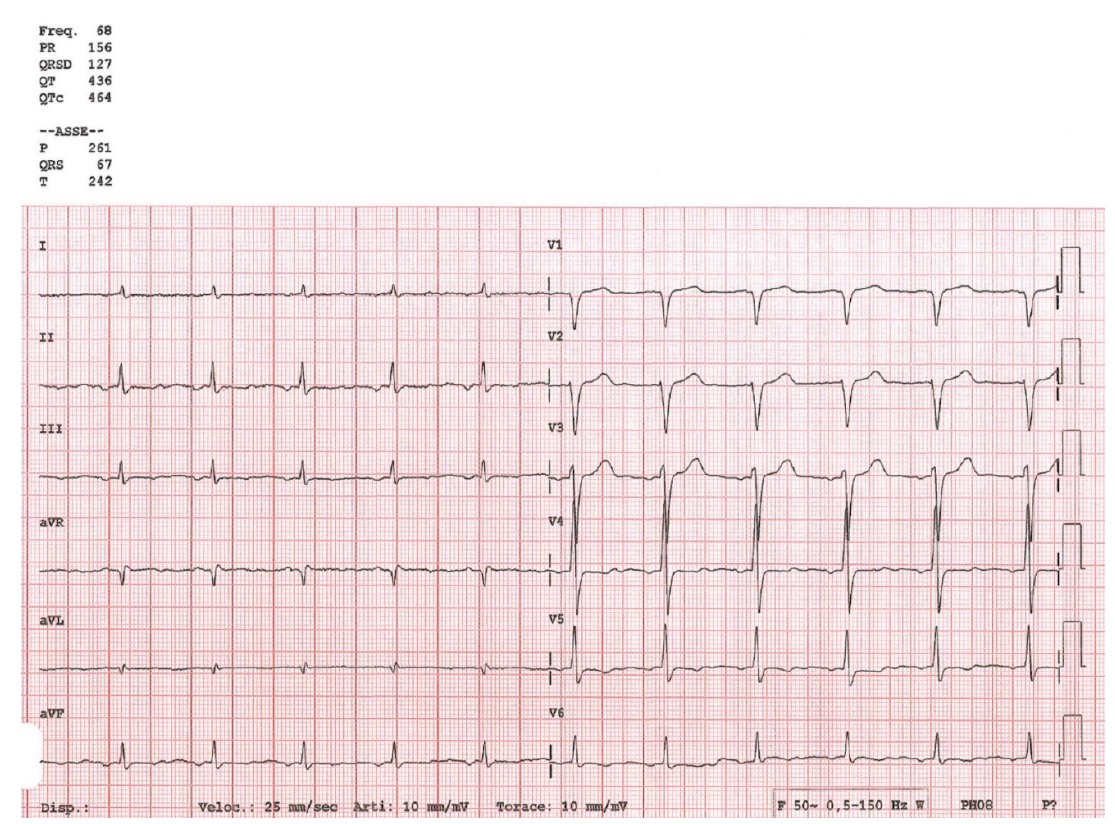
Figure 2. Electrocardiogram of the proband showing incomplete left bundle branch block.